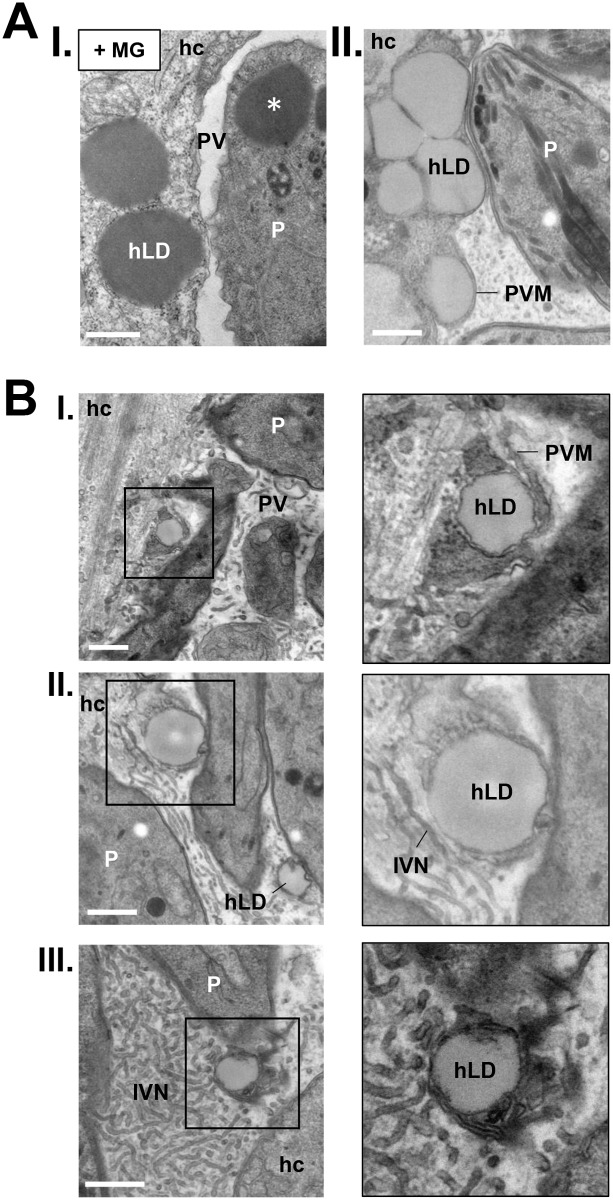
Ultrastructural evidence of host LD projection and trapping into the PV.A-B. Transmission EM of Toxoplasma-infected HFF for 24 h. In A, panel I: infected cells were fixed in the presence of malachite green (MG) to facilitate the identification of LD while in panel II, infected cells were incubated with 0.2 mM OA to increase LD number. In both situations, host LD (hLD) were observed protruding from the host cytoplasm into the PV lumen. The asterisk points to parasite LD. In B, infected cells were loaded with 0.2 mM OA and host LD were observed in the vacuolar space, wrapped by IVN tubules (panels I-III). hc, host cell; P, parasite; PVM, PV membrane. All scale bars, 0.5 μm.